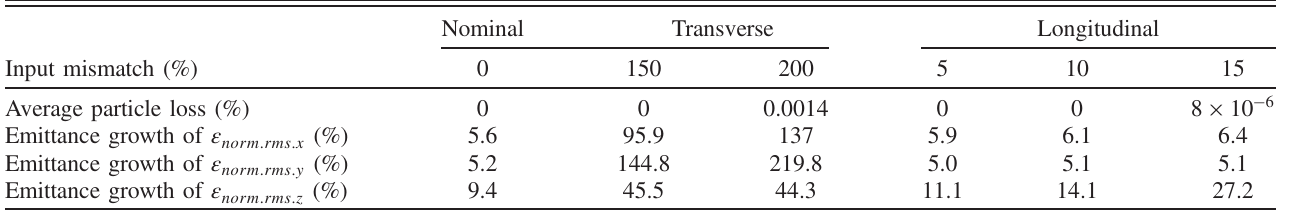
Input mismatch (%) Average particle loss (%) Emittance growth of ε Emittance growth of ε Emittance growth of ε